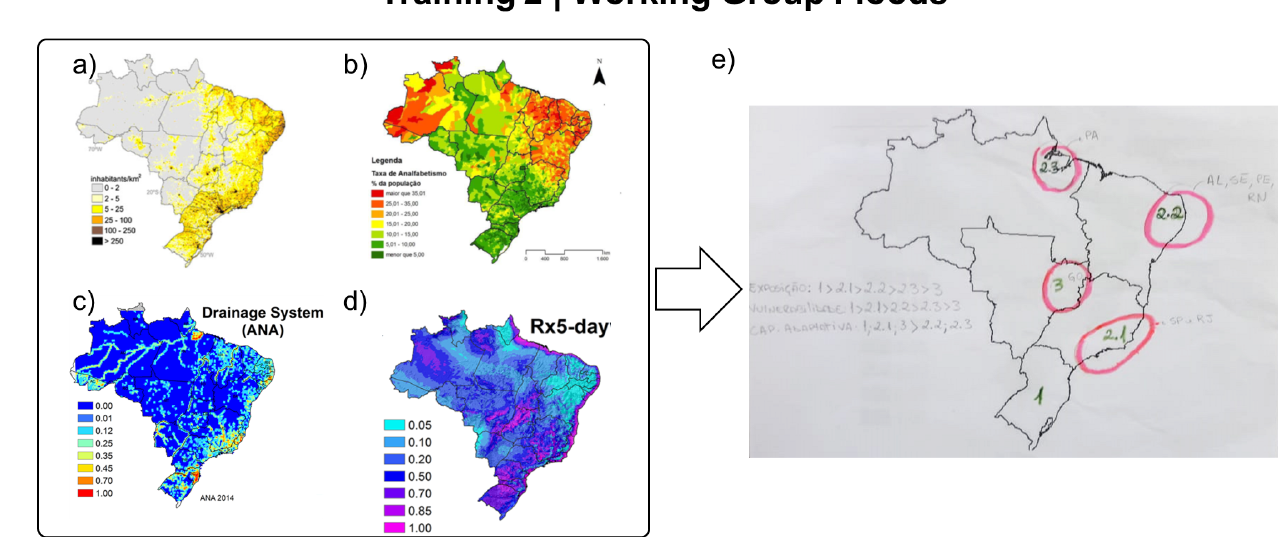
Figure A5. Package of maps used in the second training for mapping climate risk associated with floods. The maps illustrate (a) Brazilian population density (Torres et al., 2012), (b) illiteracy rate (MMA, 2017), (c) watershed drainage (Debortoli et al., 2017), (d) maximum consecutive 5d precipitation (Rx5-day; Debortoli et al., 2017), and (e) the climate risk map drawn by the